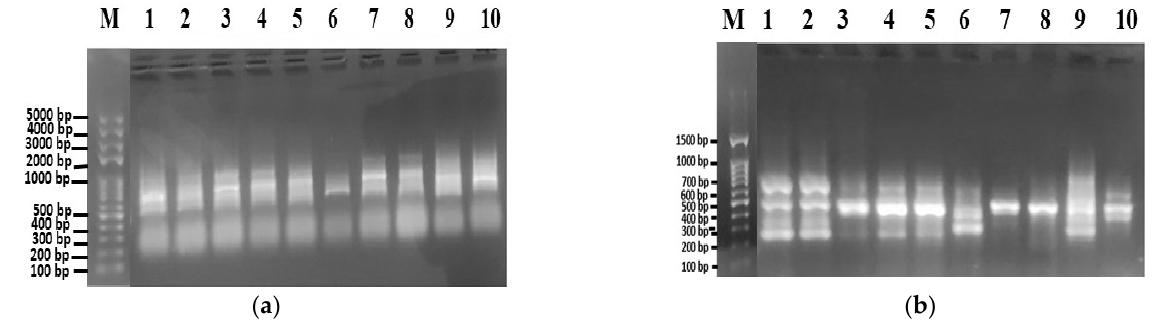
Figure 4. ( a , b ) Gel amplification profiles obtained typically with primers SCoT 35, 46, respectively.